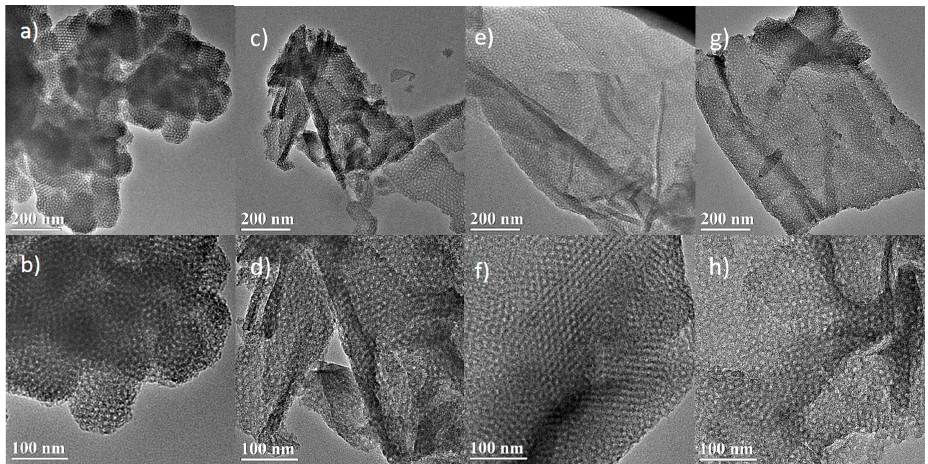
Figure 1. TEM images of the SiO 2 /GO- x (GO: graphene oxide; x: GO concentration): ( a , b ) x = 0; ( c , d ) x = 2.32; ( e , f ) x = 4.64; ( g , h ) x = 9.28.